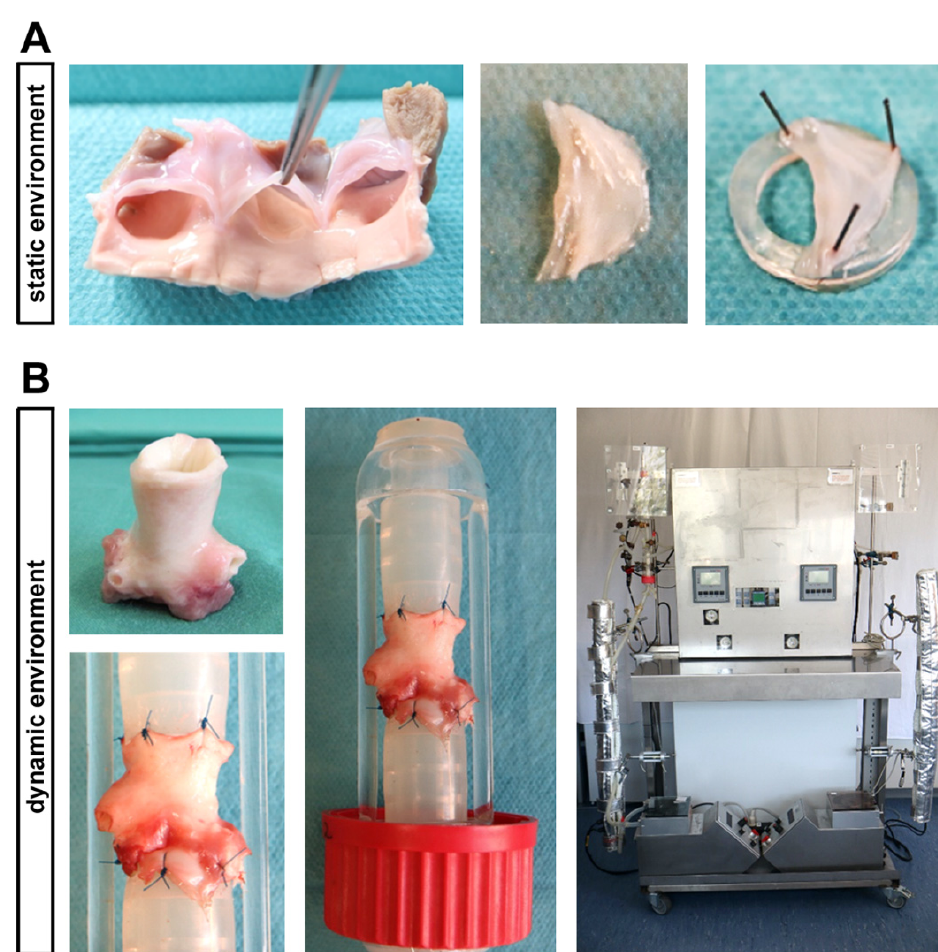
Figure 1. Ovine aortic valve (AV) cultivation in a static in vitro environment versus an ex vivo cultivation with dynamic flow in a bioreactor system. ( A ) In the static cultivation environment, AV leaflets were stretched with needles on a small silicone ring and were cultivated in culture plates.